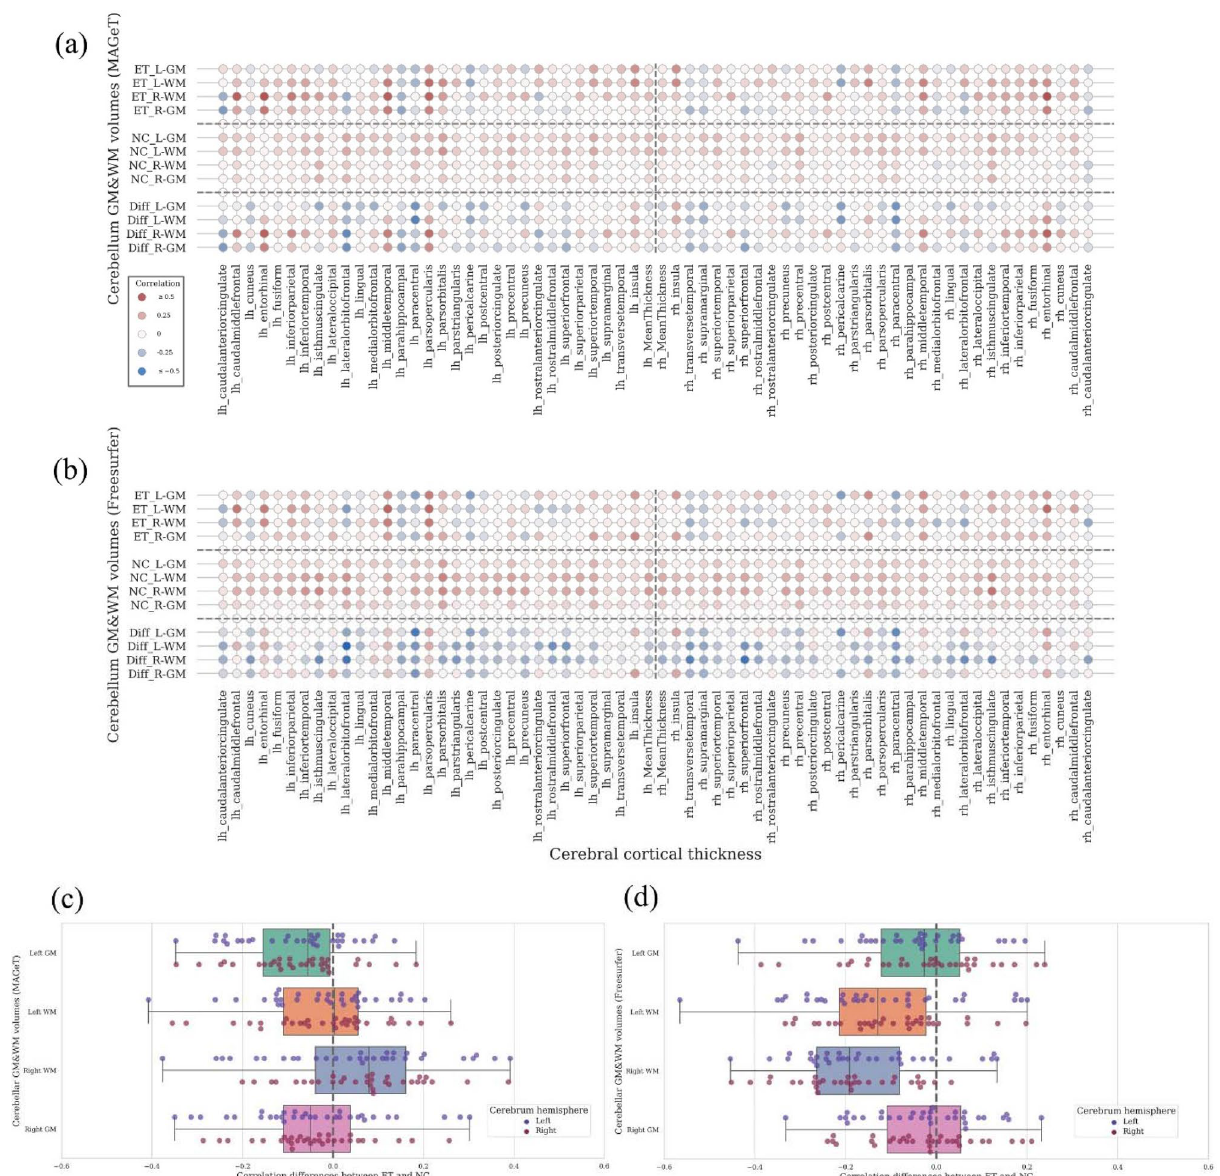
Figure 4. Structural covariances between cerebellar GM & WM volumes and cortical thickness (DKT atlas). ( a ) Structural covariances of ET and NC group and their differences (MAGeT). ( b ) Structural covariances of ET and NC group and their differences (Freesurfer) ( c ) The distribution of structural covariance differences between ET and NC (MAGeT); ( d ) The distribution of structural covariance differences between ET and NC (Freesurfer). Gray vertical lines in ( c , d ) are 0 differences, negative differences mean the reduction structural covariance of ET. All of the cortical thickness measures have been controlled for the effect of age, sex and cohort, and cerebellar GM & WM volumes have been corrected for age, sex, cohort, and